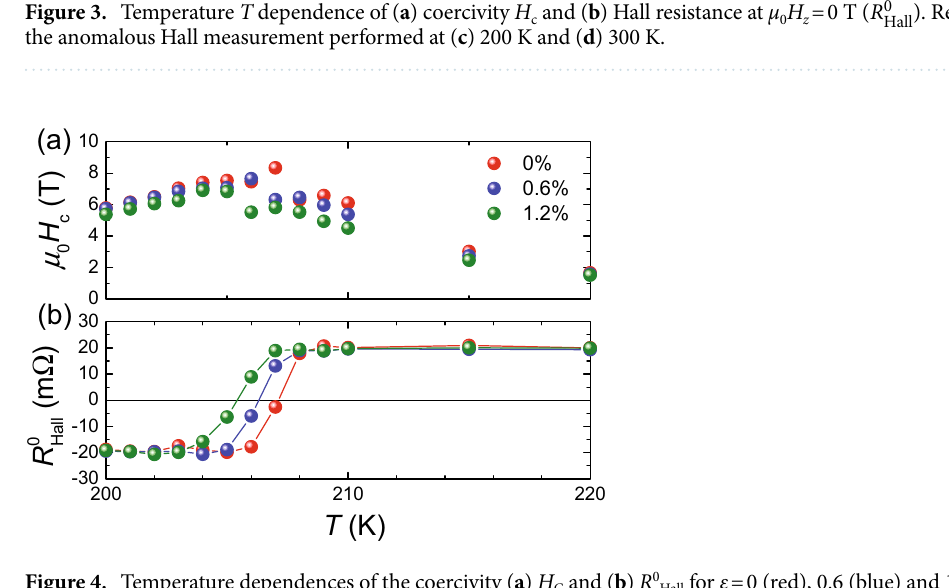
Figure 4. Temperature dependences of the coercivity ( a ) H C and ( b ) R 0 Hall for ε = 0 (red), 0.6 (blue) and 1.2% (green) obtained using Tb/Co ferromagnetic